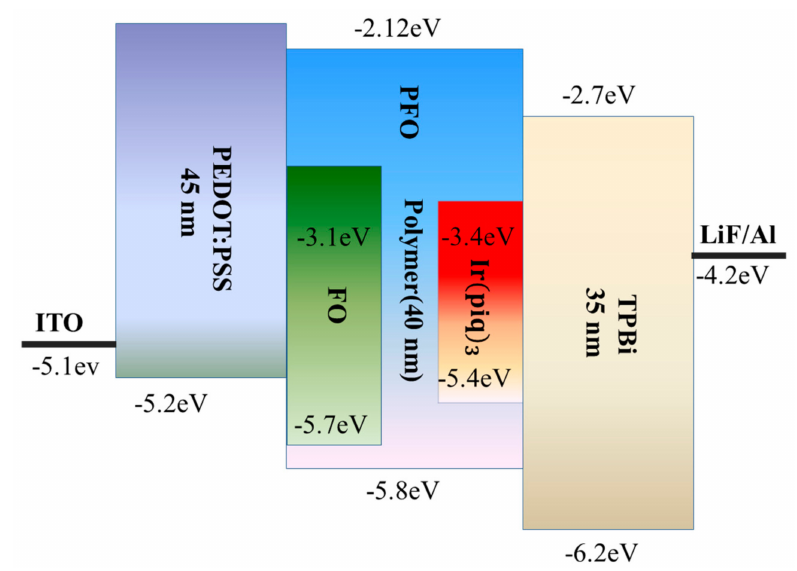
Figure 2. Device structure and energy levels of the